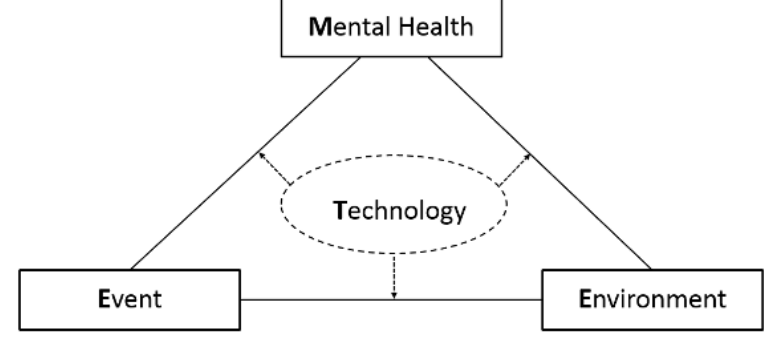
Figure 1. The MEET (Mental Health, Environment, Event, and Technology) framework.